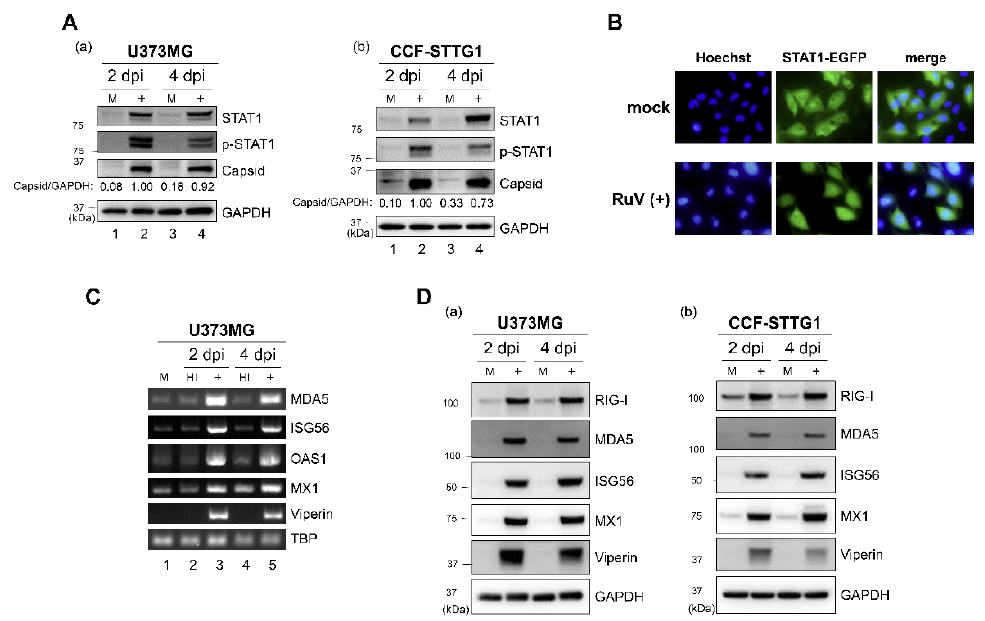
Figure 2. RuV infection induces STAT1 activation and ISG expression. ( A ) Protein lysates from U373MG cells ( a ) or CCF-STTG1 cells ( b ) that were uninfected (M) or infected with RuV RA27/3 strain (+) at 2 and 4 days postinfection (dpi) (MOI of 1.8) were analyzed by immunoblotting for STAT1, Tyr701-phosphorylated STAT1 (p-STAT1), and RuV-encoded capsid protein. GAPDH protein expression was analyzed as a reference. Densitometric analysis of the capsid protein was performed with NIH ImageJ software. Signal intensity of the capsid protein was normalized to that of GAPDH, then shown as a relative ratio of U373MG cells infected with RuV at 2 dpi. ( B ) STAT1-EGFP fusion protein (green) translocated to the nucleus was detected in RuV-infected U373MG-STAT1-EGFP cells at 2 dpi by fluorescence microscopy. Typical cells positive for nuclear localization of EGFP fusion protein are shown. Nuclei were counterstained with Hoechst 33342 (blue). Images were acquired at a magnification of 40 × objective lens. ( C ) Total RNAs extracted from U373MG cells infected with RuV RA27/3 strain (+) or heat-inactivated RuV RA27/3 strain (HI) or uninfected (M) at 2 and 4 dpi were subjected to RT-PCR for the detection of expression of MDA5, ISG56, OAS1, MX1, and viperin mRNAs. TBP mRNA was analyzed as a reference. The PCR products were analyzed by agarose gel electrophoresis. ( D ) Protein lysates from U373MG cells ( a ) or CCF-STTG1 cells ( b ) that were uninfected (M) or infected with RuV RA27/3 strain (+) at 2 and 4 dpi (MOI of 1.8) were analyzed by immunoblotting for the protein expression of ISGs (RIG-I, MDA5, ISG56, MX1, and viperin). Glyceraldehyde-3-phosphate dehydrogenase (GAPDH) protein was analyzed as a reference.